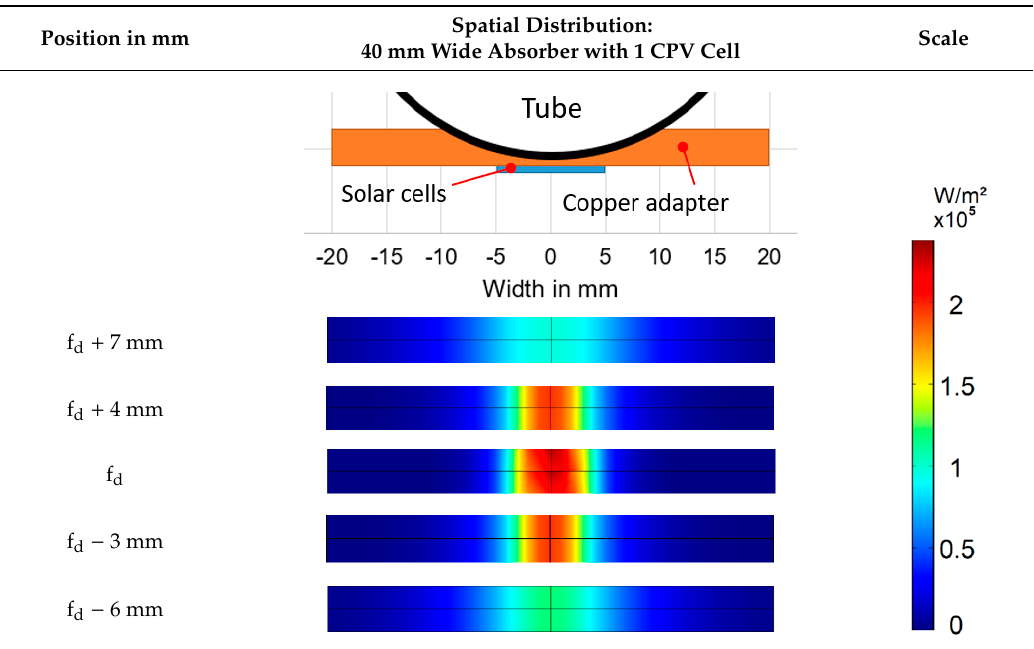
( b ) Figure 10. ( a ) Shows the spatial distribution of different receiver positions of the medium concentration setup. ( b ) Depicts the to ( a ) associated simulation setup, where the focal point f d is located and how the absorber tube is positioned. Table 4. Ray tracing simulation of the medium concentration setup to depict the influence of the absorber position on peak flux and flux distribution. Position in mm Spatial Distribution: 80 mm Wide Absorber with 2 CPV